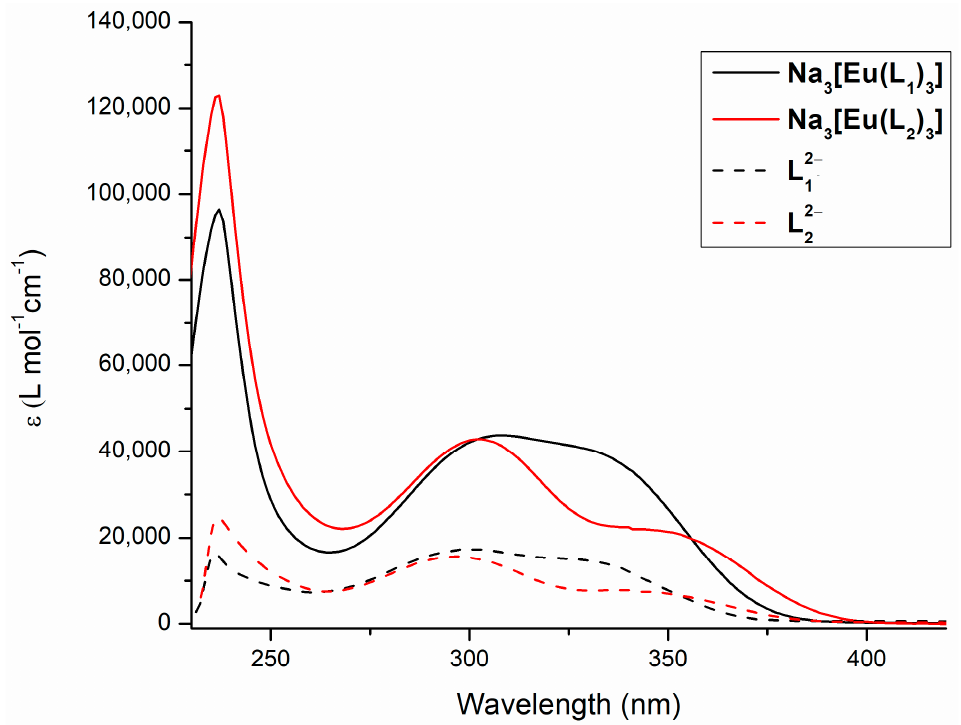
Figure 5. Absorption spectra comparison in water of Na 3 [Eu(L 1 ) 3 ] and Na 3 [Eu(L 2 ) 3 ] complexes and L 12 − and L 22 − ligands (triethylammonium